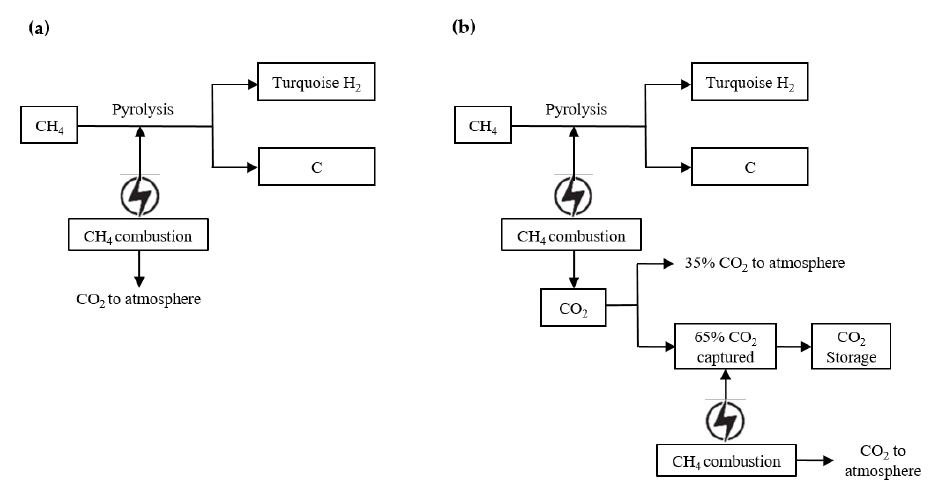
Figure 3. PFD of ( a ) turquoise hydrogen (NG-NG) and ( b ) turquoise hydrogen (NG-NG) with FGC .